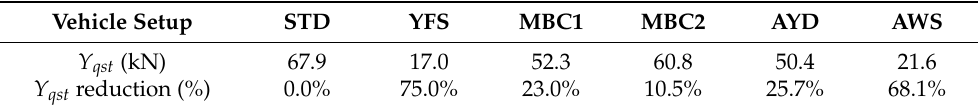
Figure 4. Quasistatic guiding force acting on outer wheel of the 1st wheelset in curve with radius R = 150 m for various vehicle configurations. Table 2. Y qst for different vehicle setups.